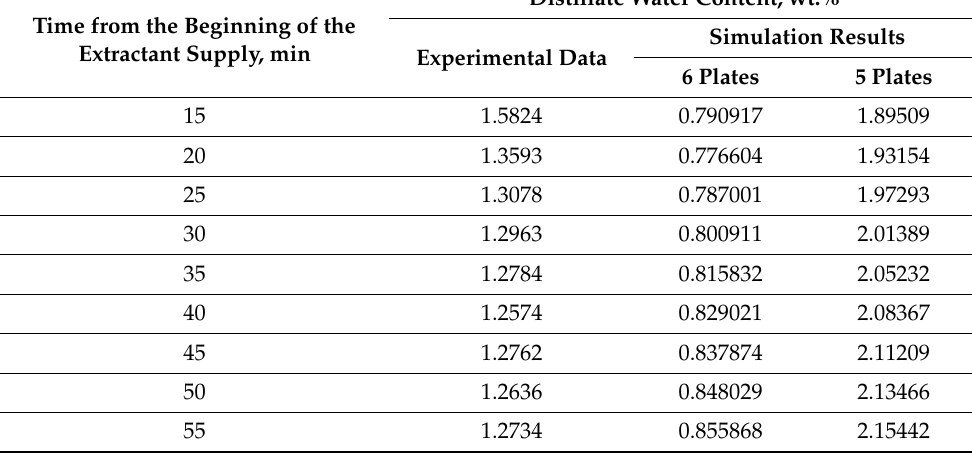
Table 6. Mass fraction of water in the distillate, determined at different times from the beginning of the AEPA-GL extractant supply. Distillate Water Content, wt.% Time from the Beginning of the Extractant Supply, min Experimental